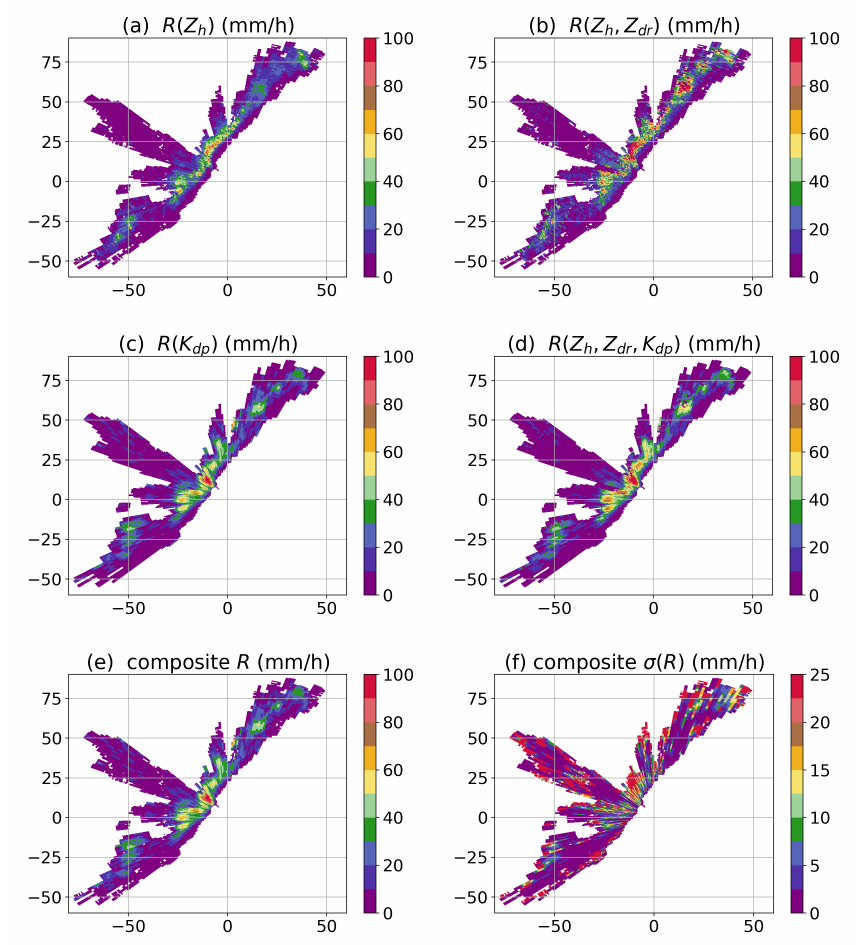
Figure 5. Plan position indicators (PPIs) of ( a ) R ( Z h ) , ( b ) R ( Z h , Z dr ) , ( c ) R ( K dp ) , ( d ) R ( Z h , Z dr , K dp ) , ( e ) composite R , and ( f ) composite σ ( R ) . The corresponding polarimetric data were presented in Figure